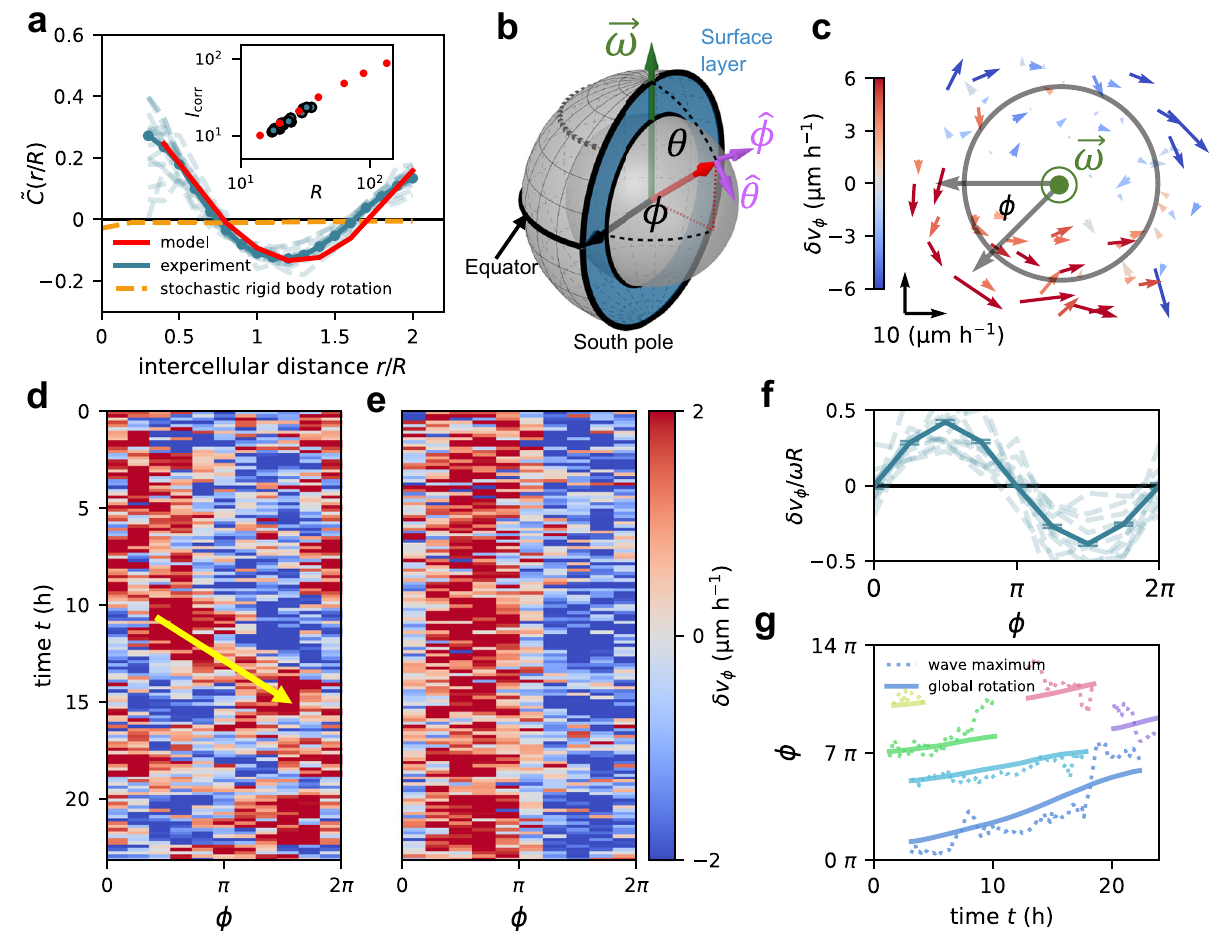
Fig. 2 | Velocity waves in rotating spheroids. a Spatial correlation function of velocity fl uctuationdirections e C ð r = R Þ .Theintercellulardistance r isrescaledbythe spheroid radius R . Dashed orange line shows the correlation function for a rigid- body rotation with additional uncorrelated Gaussian noise (Supplementary Sec- tion2).Solidredlineshowsthemodelresult.Insetshowsthecorrelationlength l corr asafunctionofspheroidradiusforboththeexperiment(blue)andthemodel(red). b Schematicofthesphericalcoordinatesystem.Theblueregionindicatesthecross section of the surface layer of the spheroids. The core region is indicated by the gray inner sphere. We choose the thresholdbetweencoreregion and surfacelayer at r =0 : 6 R . Schemati c created with Geogebra. c Planar projection of the velocity fl uctuation fi eld δ v in a slab centered around the equatorial plane. The color code indicates δ v ϕ ,the ϕ -componentof δ v ,andthearrowscaleisshowninthelowerleft corner. The gray circle indicates the threshold between the core and the surface